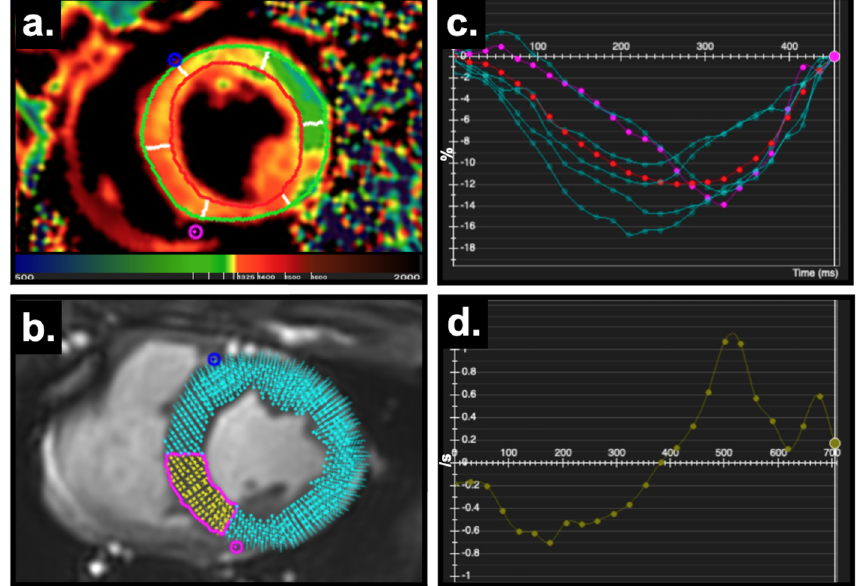
Figure 1. CMR as a non-invasive tool for assessing regional tissue, systolic and diastolic abnormalities. ( a ) T1 map with the left ventricle segmented into six territories; orange depicts higher T1 after the intervention, ( b ) feature tracking strain highlighting the inferoseptal segment, ( c ) circumferential strain curve of each of the six segments displaying mechanical dispersion after the electrical intervention (pink highlighted inferoseptal segment in ( b ), red is the global strain curve) and ( d ) strain rate